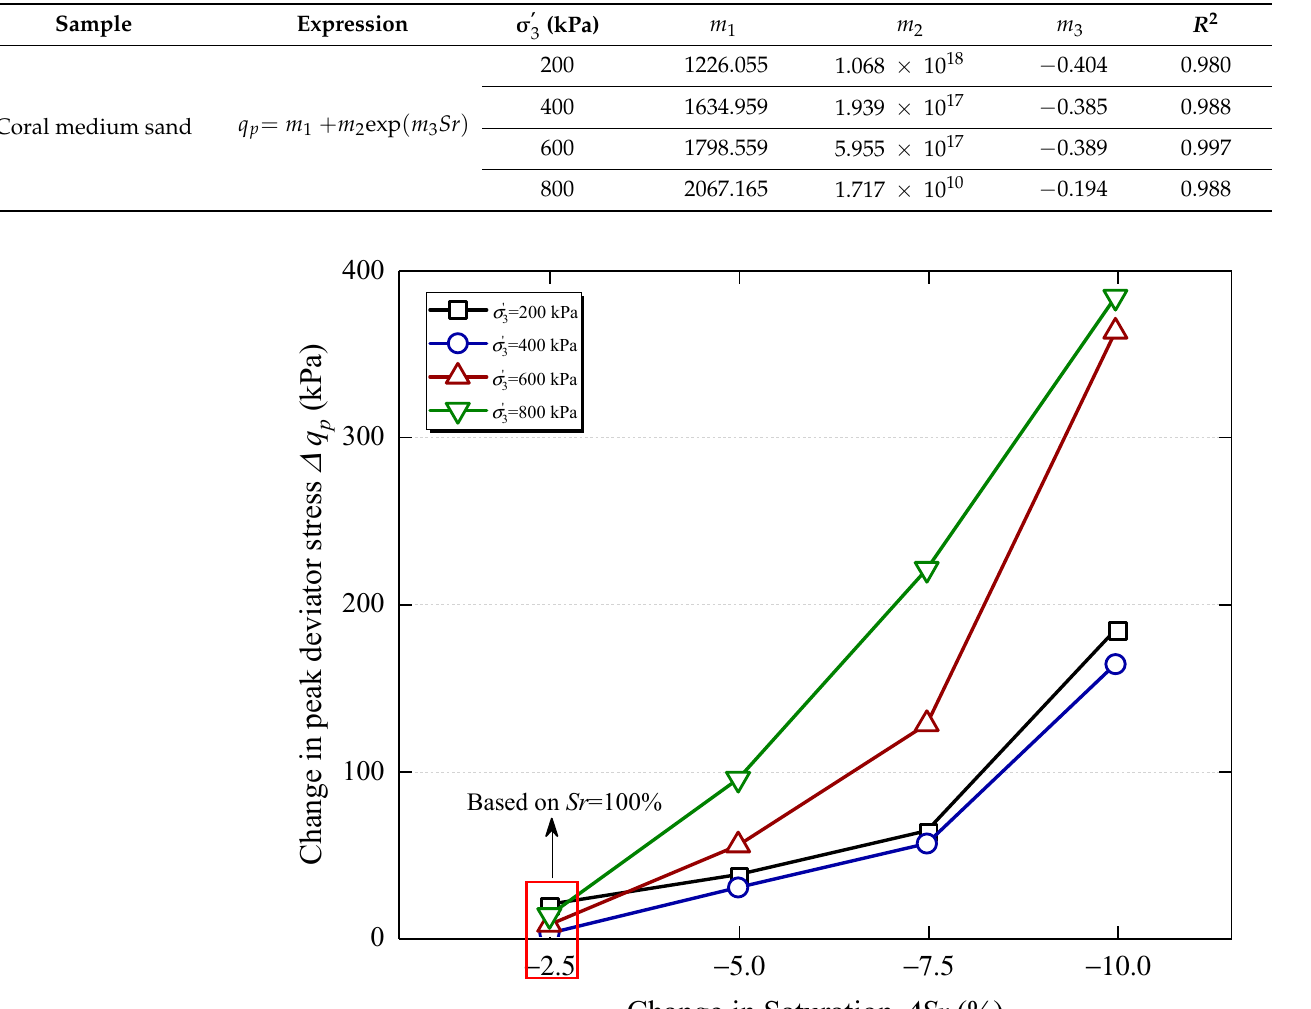
Table 6. Peak deviator stress–saturation fitting expression and parameters.